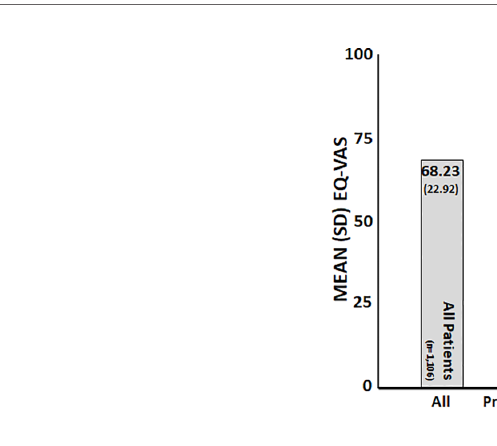
FIGURE 3 | Patient-reported EuroQol ’ s visual analogue scale (EQ-VAS) by subgroup. EQ-VAS was measured at the time of the survey, and patient and clinical characteristics were self-reported by patients at the time of the survey. Higher values indicated improved self-rated health, and lower values indicated worse self- rated health. P -values were calculated using the